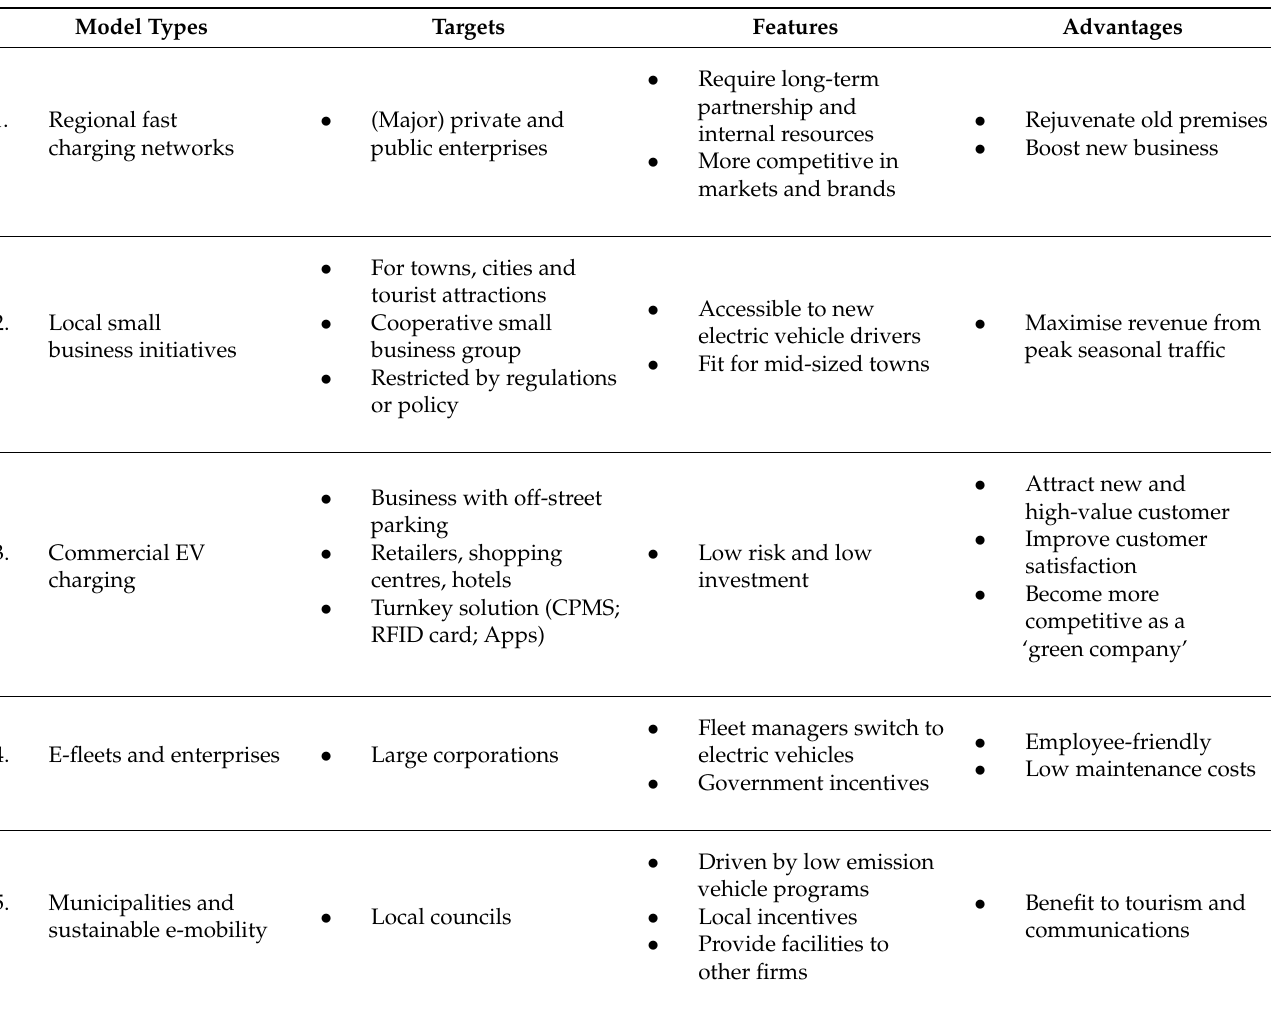
Table 4. Five EV charging business models